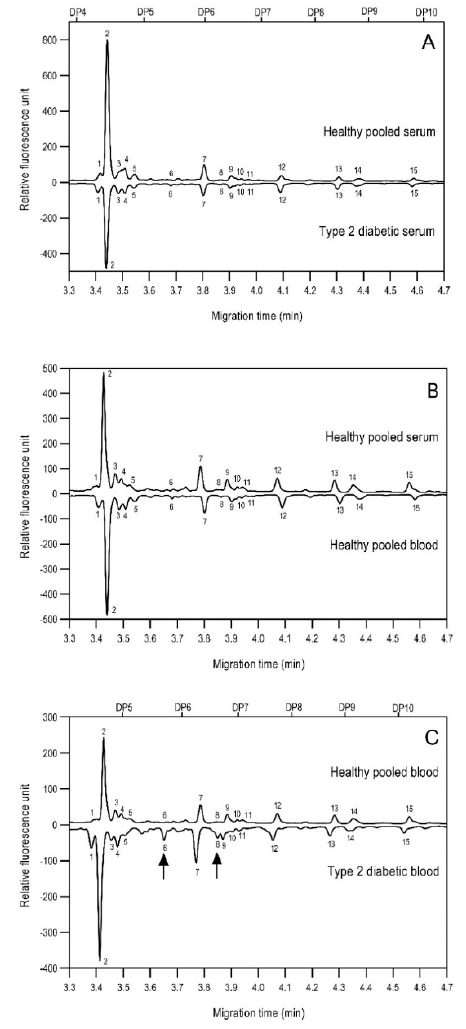
Figure 2. Comparison of the N -glycome of healthy and type 2 diabetic serum and blood samples. Panel ( A )—healthy pooled vs. T2 diabetic serum sample, Panel ( B )—healthy blood vs. healthy serum sample, ( C )—healthy pooled vs. T2 diabetic blood sample with the indication of potential biomarker peaks by the arrows. Separation conditions were the same as in Figure 1. Structures corresponding to peaks: 1: FA4BG4S4, 2: A2G2S2, 3: A2BG2S2, M3, 4: FA2G2S2, 5: FA2BG2S2, 6: FA2G1S1, 7: A2G2S1, 8: A2BG2S1, 9: FA2G2S1, 10: FA2BG2S1, 11: A4G4S2, 12: FA2, M6, 13: FA2[6]G1, M7, 14: FA2[3]G1, FA2BG1, M8, 15: FA2G2.